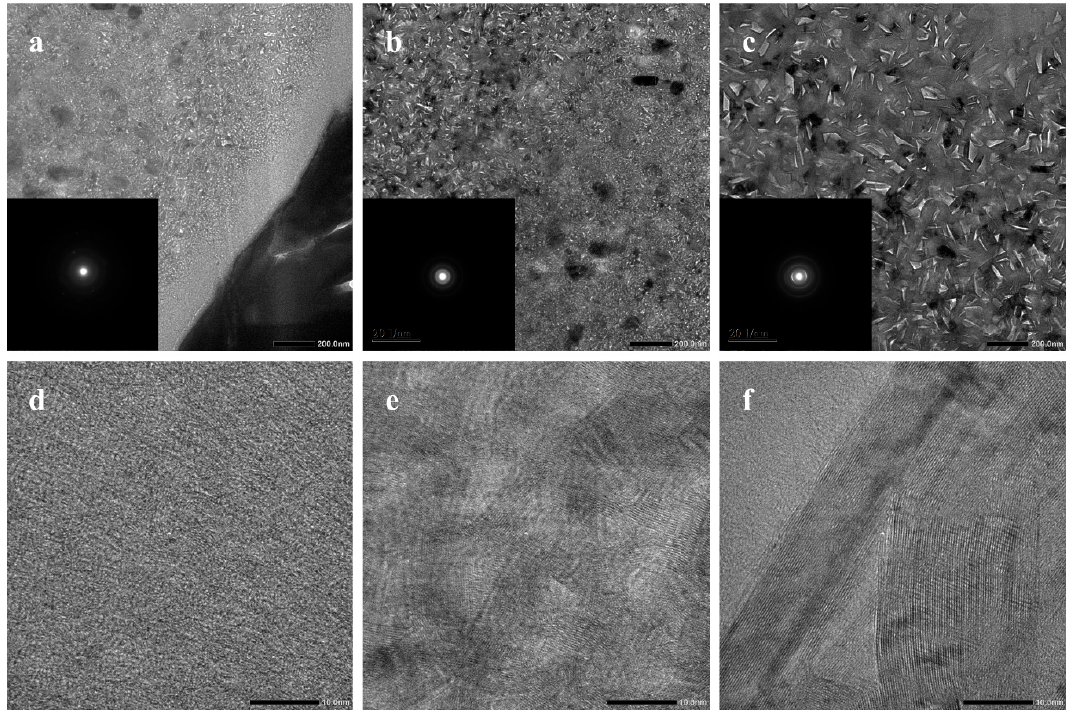
Figure 6. Cross-sectional HR-TEM images of the composite fiber taken at different locations: ( a , d ) show the shell, ( b , e ) show near the shell, and ( c , f ) show the core at low and high magnifications.